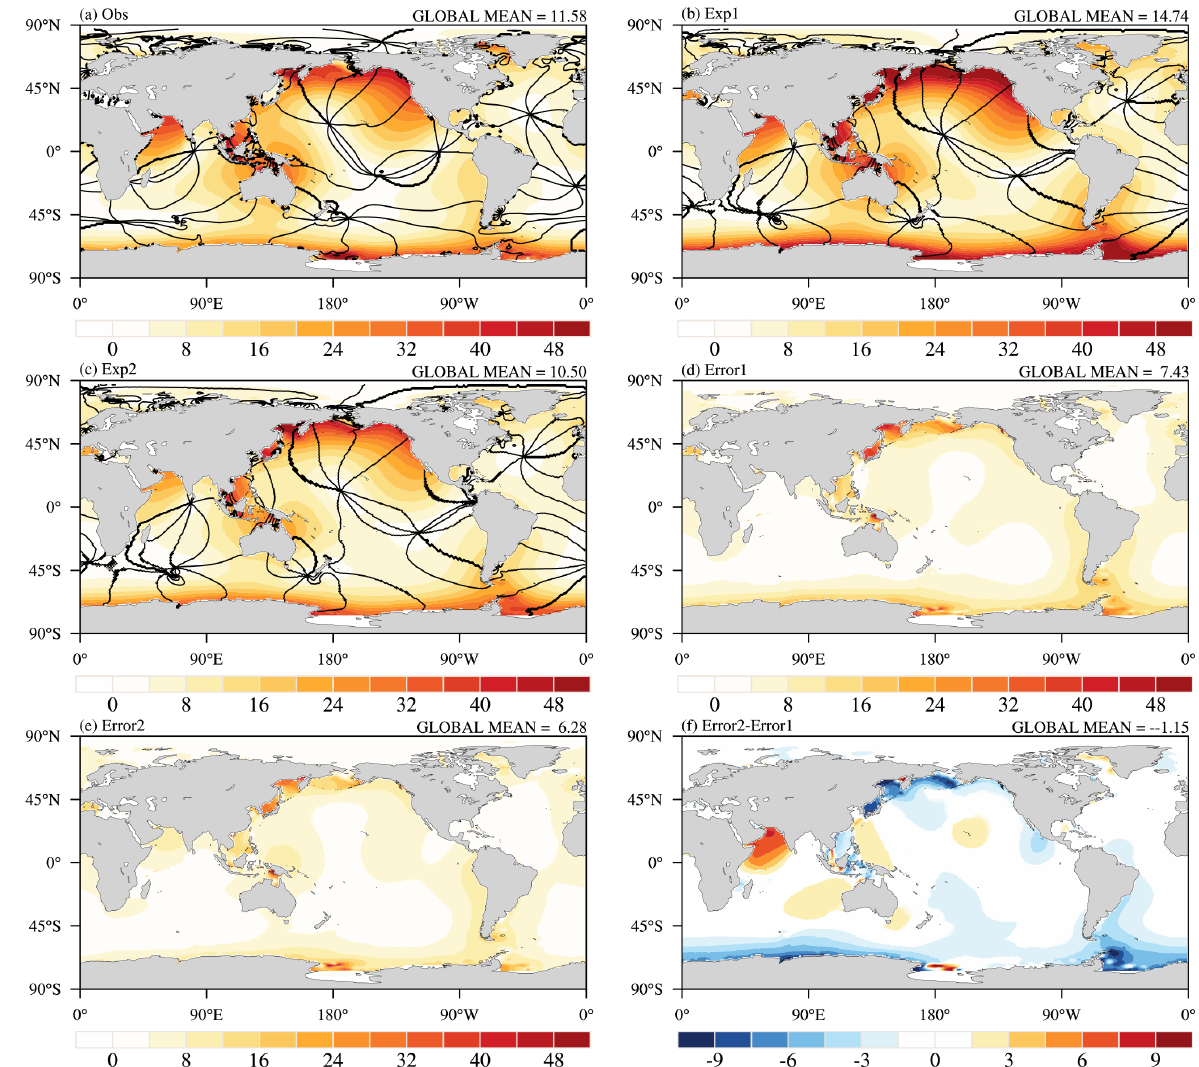
Figure 4. Spatial patterns of the amplitude and phase of K1 for (a) the observation (Obs), (b) Exp1, (c) Exp2, (d) the total error for Exp1, (e) the total error for Exp2, and (f) the difference in error between Exp2 and Exp1. The observation is from TPXO9v2 (Egbert and Erofeeva, 2002). The units are centimeters, and the lines of the constant phase are plotted every 45 ◦ in